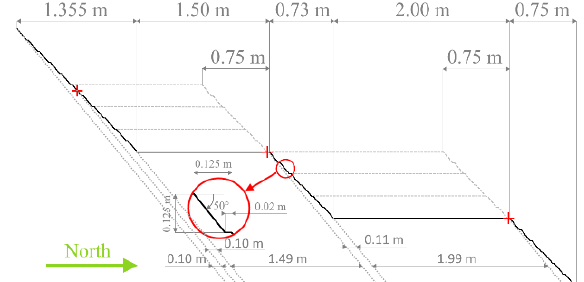
Figure 6. Upper view of the synthetic wall with its dimensions in meters (black line as horizontal